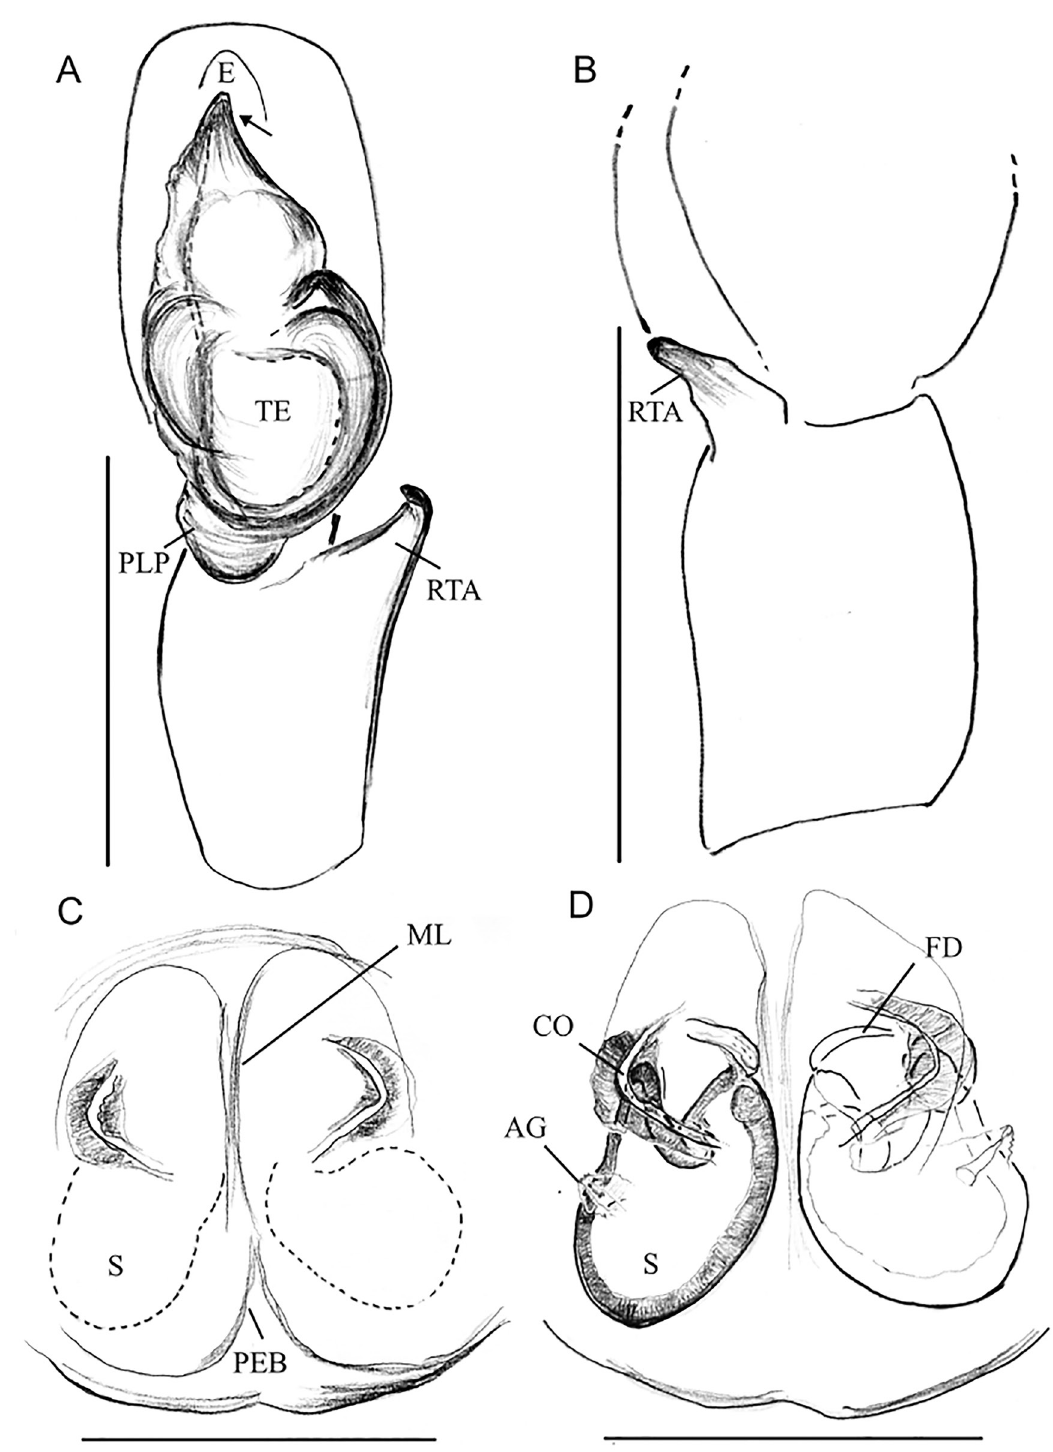
Fig 14. Carrhotus taprobanicus Simon, 1902. A–B . Palp. A . Ventral view. B . Retrolateral view. C–D . Epigynum. C . Ventral view. D . Dorsal view. Abbreviations: AG = accessory gland; CO = copulatory opening; E = embolus; FD = fertilization duct; PEB = posterior epigynal border; PLP = posterior lateral protrusion; RTA = retrolateral tibial apophysis; S = spermatheca; TE = tegulum. Scale bars: A–B = 0.2 mm; C–D = 0.1